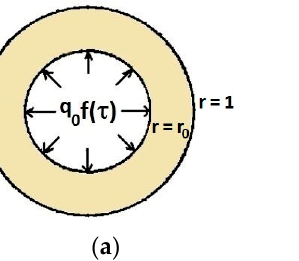
Figure 6. Loading conditions ( a ) cylinder of FGM; ( b ) piecewise homogeneous cylinder.